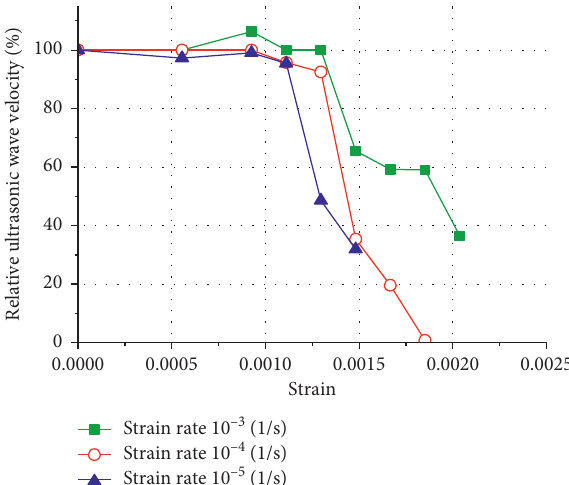
Figure 3: Relative ultrasonic wave velocity of concrete samples subject to the cyclic compressive loading process.